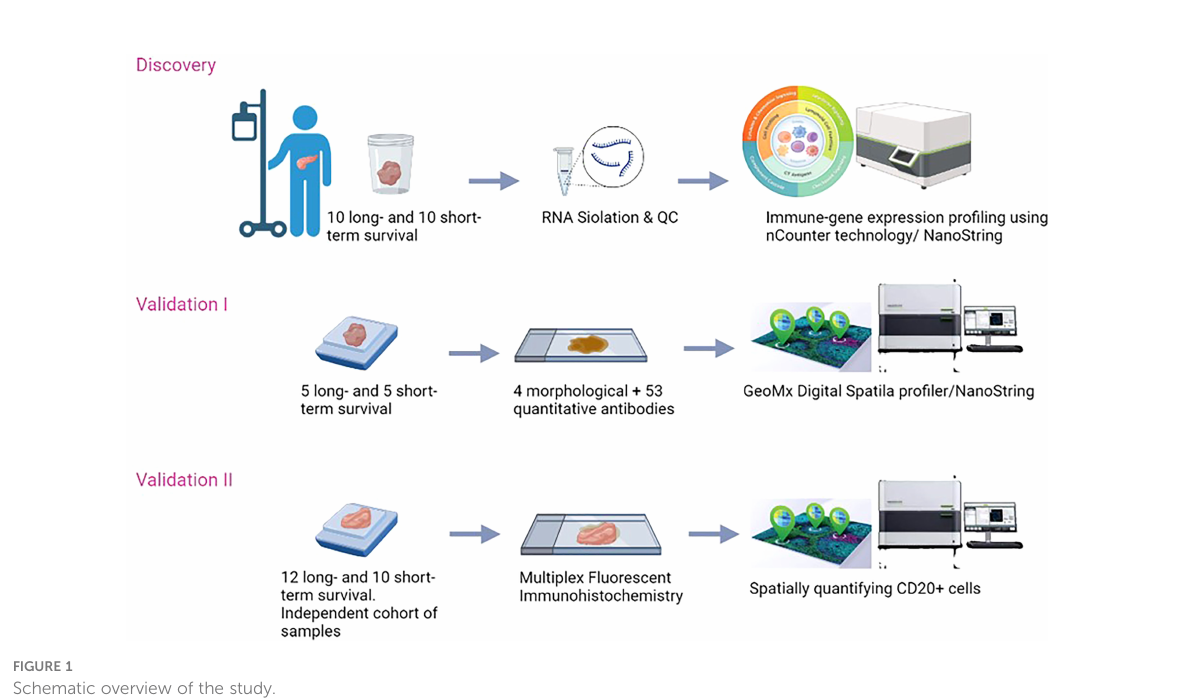
FIGURE 1 Schematic overview of the